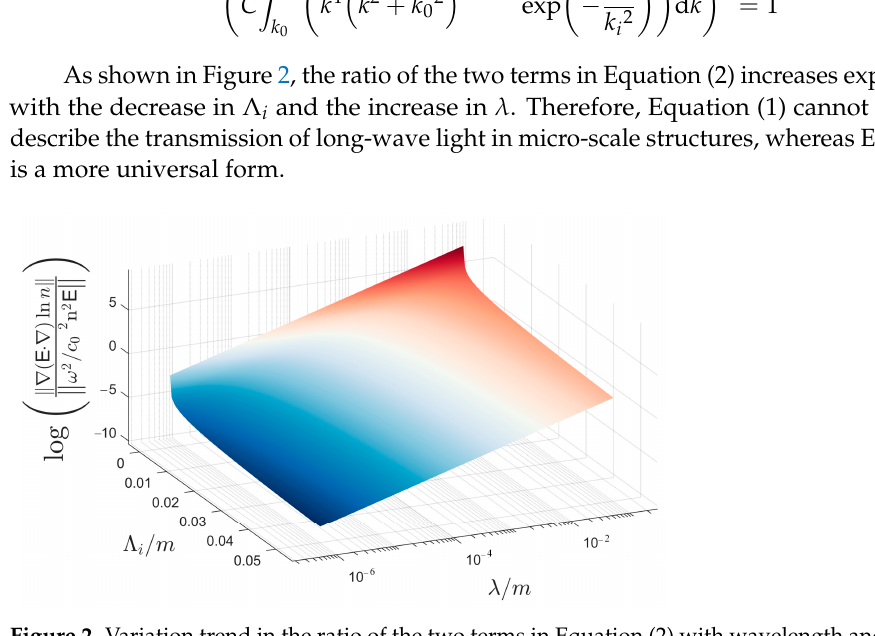
( b ) Figure 3. The refractive index distribution resolved by computational fluid dynamics (CFD) mesh and the actual distribution of air molecules: ( a ) Molecules are uniformly distributed in a grid; ( b ) molecules are nonuniformly distributed in a grid. To analyze the influence of micro-scale structures on the incident light, we need a new aero-optical simulation technique. In Section 3, a transient simulator that can simu- late the distorted wavefront caused by structures of all sizes without precision mesh is developed. 3. Design of the Transient Simulator for Aero-Optical Effects Caused by Micro-Scale Structures Molecules in the flow field are in high-speed movement. Large-scale structures are generally considered stable. The steady-state simulator [9] we designed, based on the steady-state hypothesis, simulates the aero-optical effects caused by large-scale structures. However, micro-scale structures are unsteady, so an aero-optical transient simulator (TSAO) is needed to simulate the high-dynamic distorted wavefront and the scattering process of the photon on its transmission path. There are two steps in the design of TSAO: